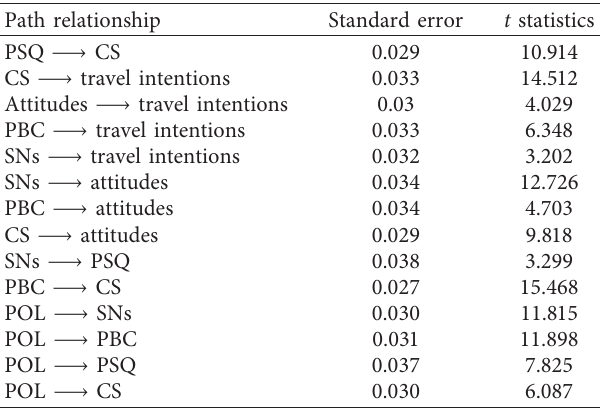
(Table 6; beta � 0.35, beta � 0.375, beta � 0.288, and